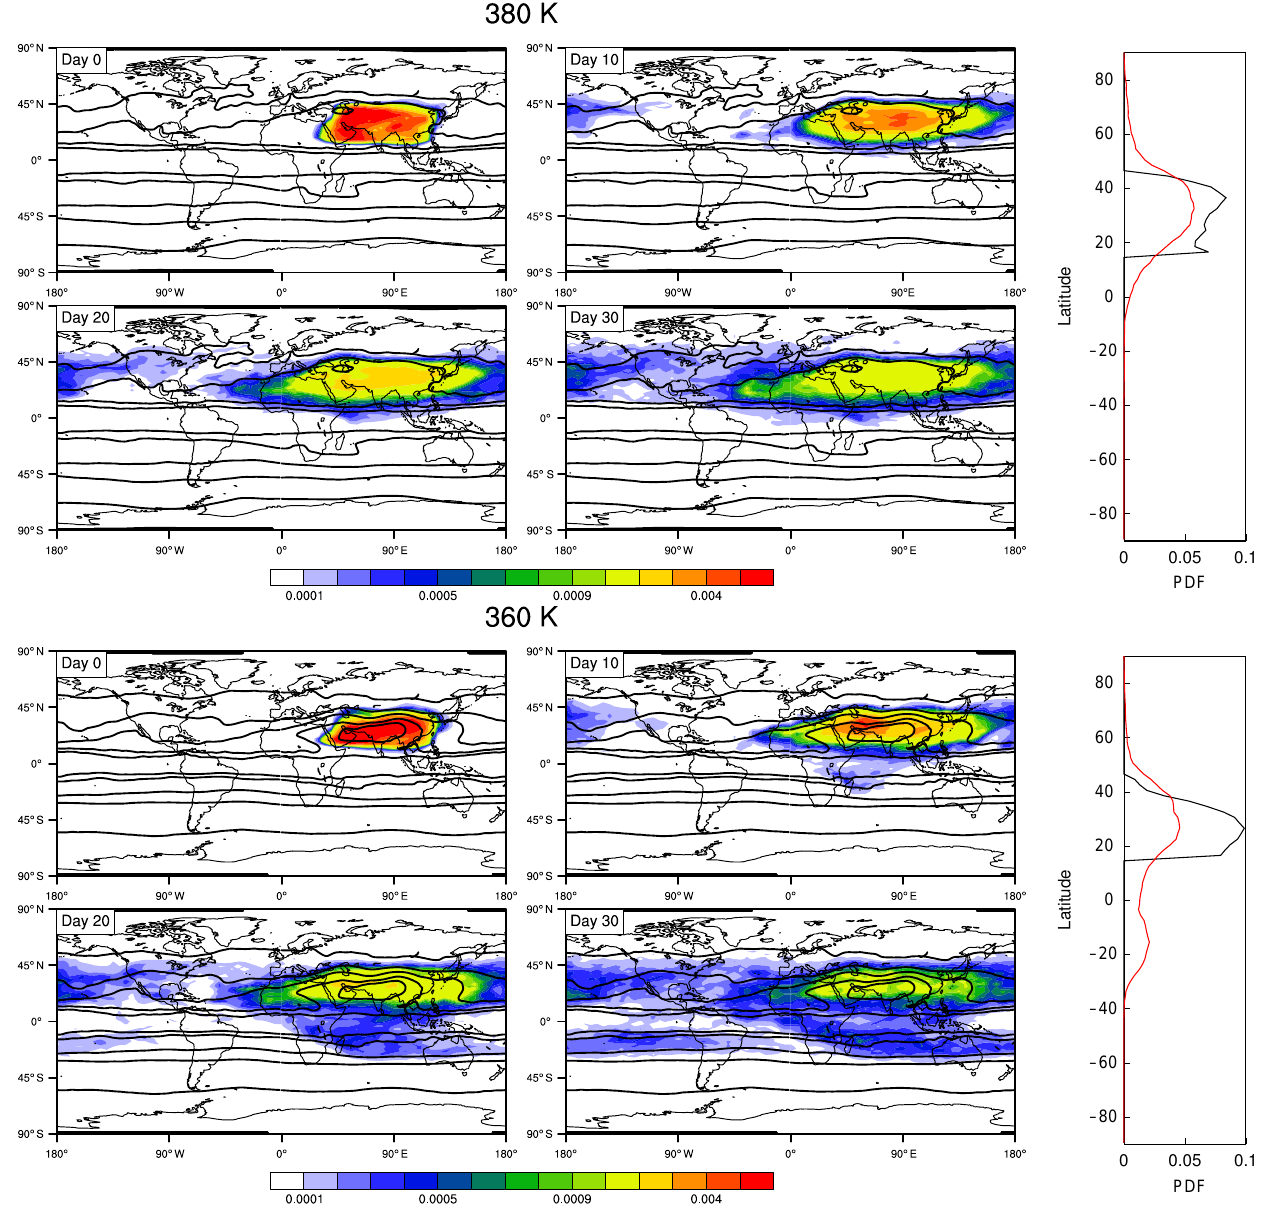
Figure 3. Mean JJA distribution of isentropic trajectories (in percentage of total number of trajectories) at the 380K (top panels) and 360K (bottom panels) level on day 0, 10, 20 and 30 after release, overlaid with mean JJA PV contours (at ± 3, 4, 6, 8 and 12PVU at 380K and ± 0.7, 1, 2, 4 and 8PVU at 360K). Panels on the right show the zonal mean distribution on day 0 (black) and 30 (red).